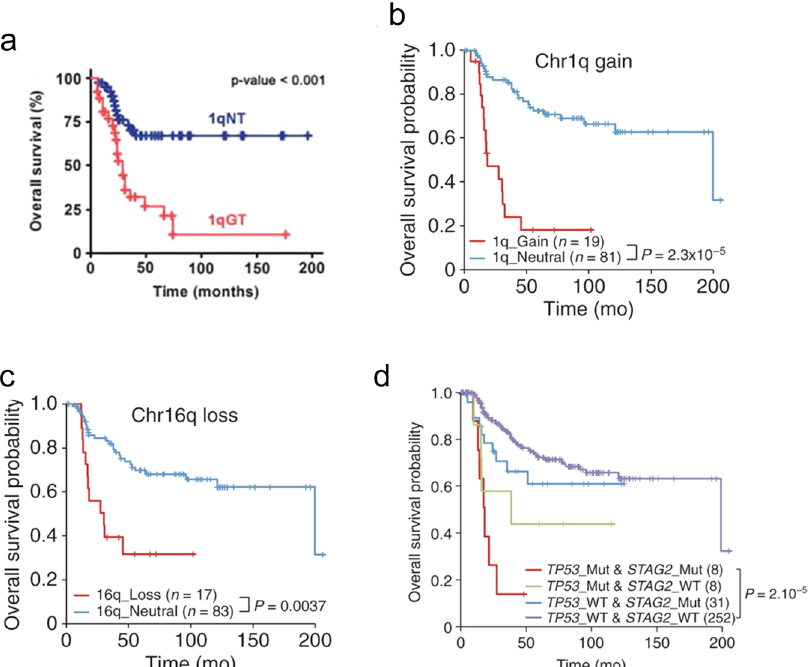
Fig. 2 Poor prognostic molecular features of Ewing sarcoma tumors. Survival curves demonstrating the prognostic impact of 1q gain shown here are adapted with permission from Mackintosh C. et al., Oncogene , 2012 64 ( a ) and Tirode F. et al., Cancer Discovery , 2014 65 ( b ). Survival curves for 16q loss are shown here adapted with permission from Tirode F. et al., Cancer Discovery, 2014 65 ( c ). Survival curves for patients strati fi ed by STAG2 and TP53 status, adapted with permission from Tirode F. et al, Cancer Discovery , 2014 65 ( d